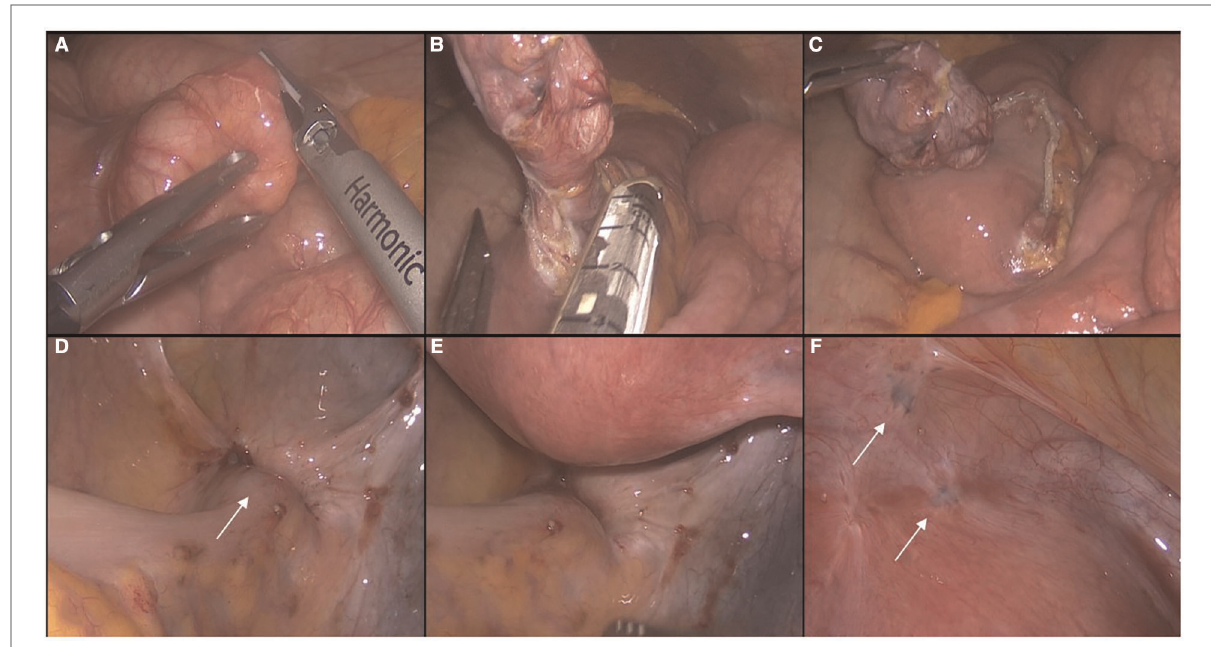
FIGURE 2 Laparoscopic exploration of the abdominal cavity; ( A ) identi fi cation of jejunal diverticulum; ( B ) isolation and excision with a linear stapler; ( C ) resected diverticulum and particular of tangential suture; ( D , E ) location of deep in fi ltrating endometriosis of the superior rectum; ( F ) other millimetric foci of endometriosis on the parietal pelvic peritoneum over the bladder-uterine